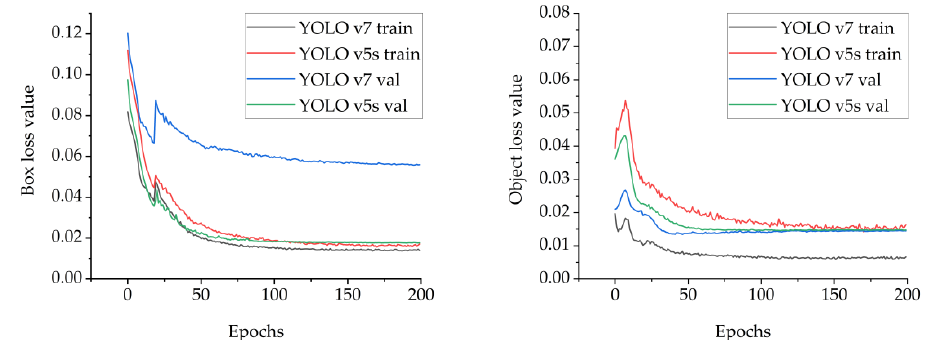
Figure 9. Loss function value curve.